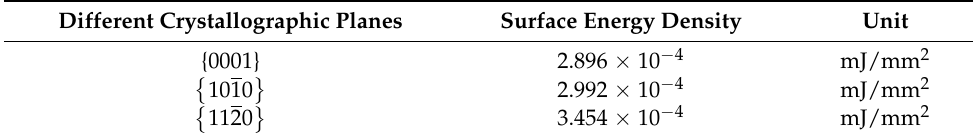
Table 2. Surface energy density for different crystallographic planes of Mg